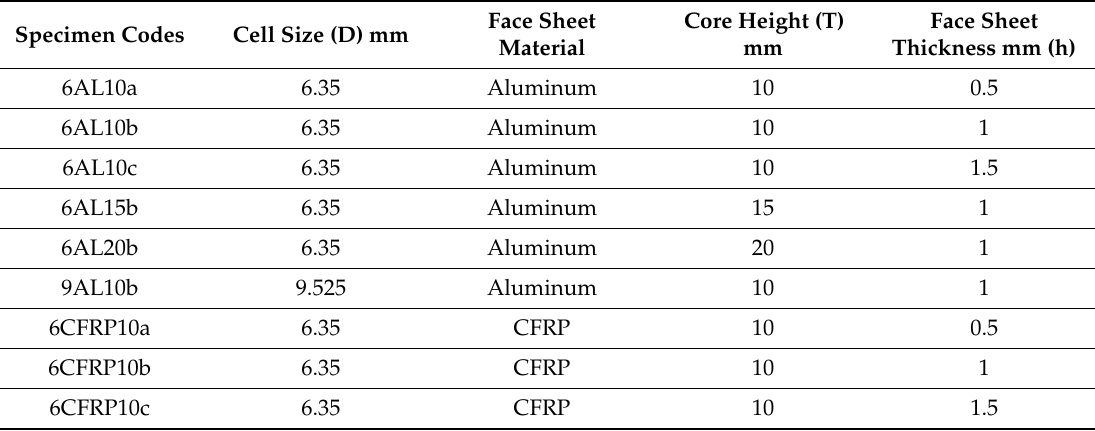
Figure 1. Honeycomb sandwich specimen layers. Table 1. Specimen properties.